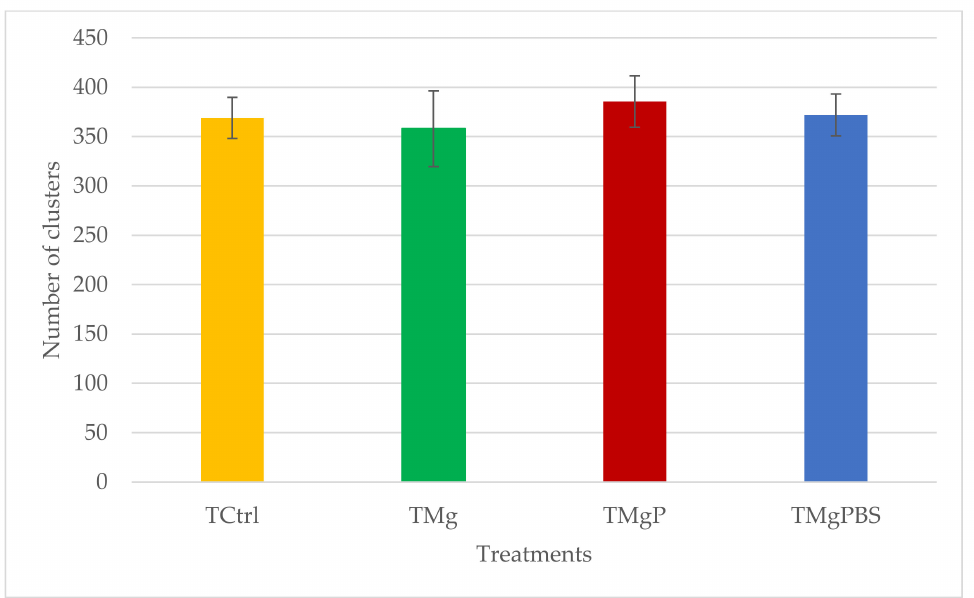
Figure 5. Number of clusters by treatment. (TCtrl—NPK, TMg—NPK + Agromag (6% MgO),